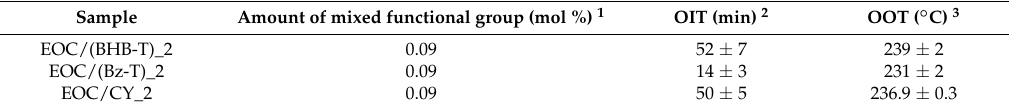
Table 4. Oxidation Induction Time (OIT) and Oxidation Onset Temperature (OOT) values for EOC mixed with BHB-T, Bz-T and CY.